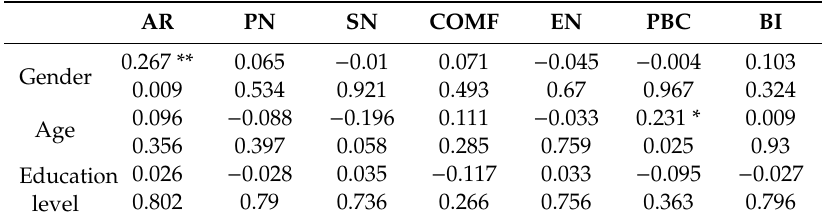
Table 13. Correlation analysis